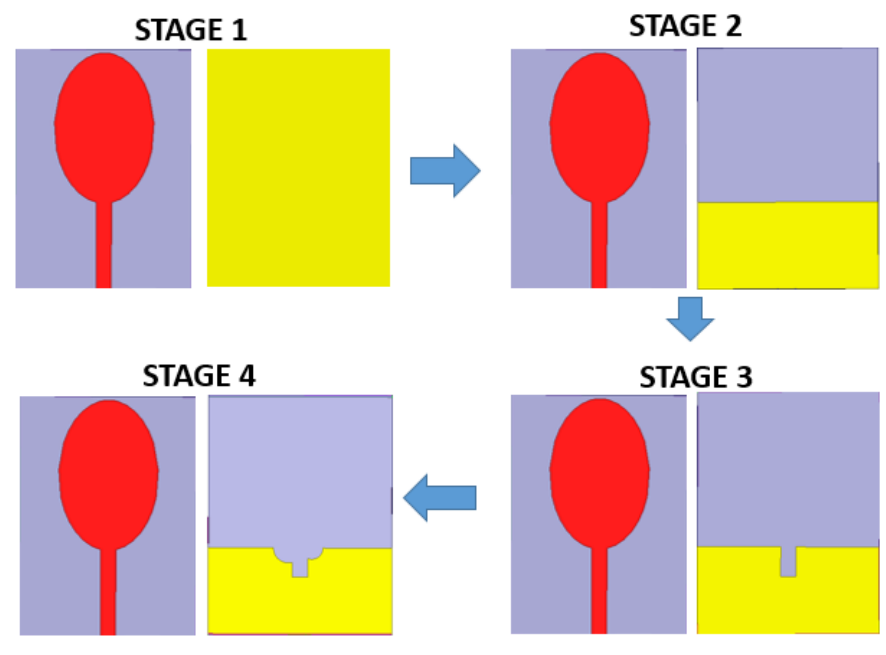
Figure 1. Progression stage of UWB antenna.